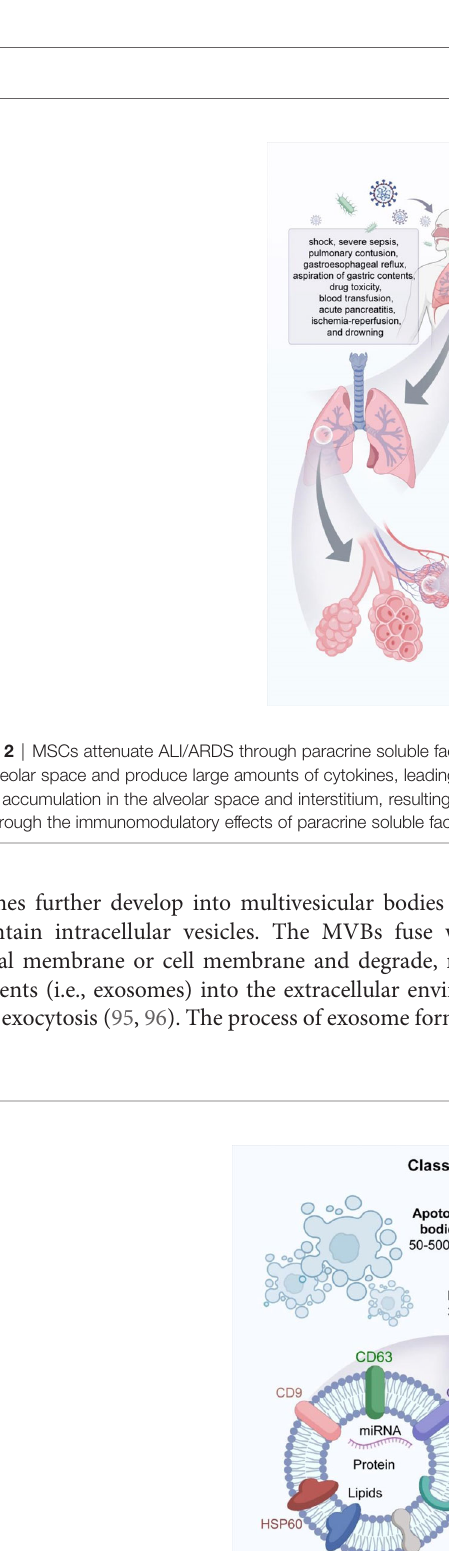
FIGURE 3 | Classi fi cation of extracellular vesicles and structural characteristics of exosomes. Extracellular vesicles can be classi fi ed into three main subtypes based on biological properties and diameter size: exosomes (30-150nm), microvesicles (100-1000nm) and apoptotic bodies (50-5000nm). The surface of exosomes contains speci fi c protein markers such as tetraspanins (CD9, CD81, CD63), HSP60, HSP70, TSG101 and Alix. Exosomes carry proteins, lipids and miRNA that are involved in mediating intercellular communication and regulating cellular activities, performing a variety of biological